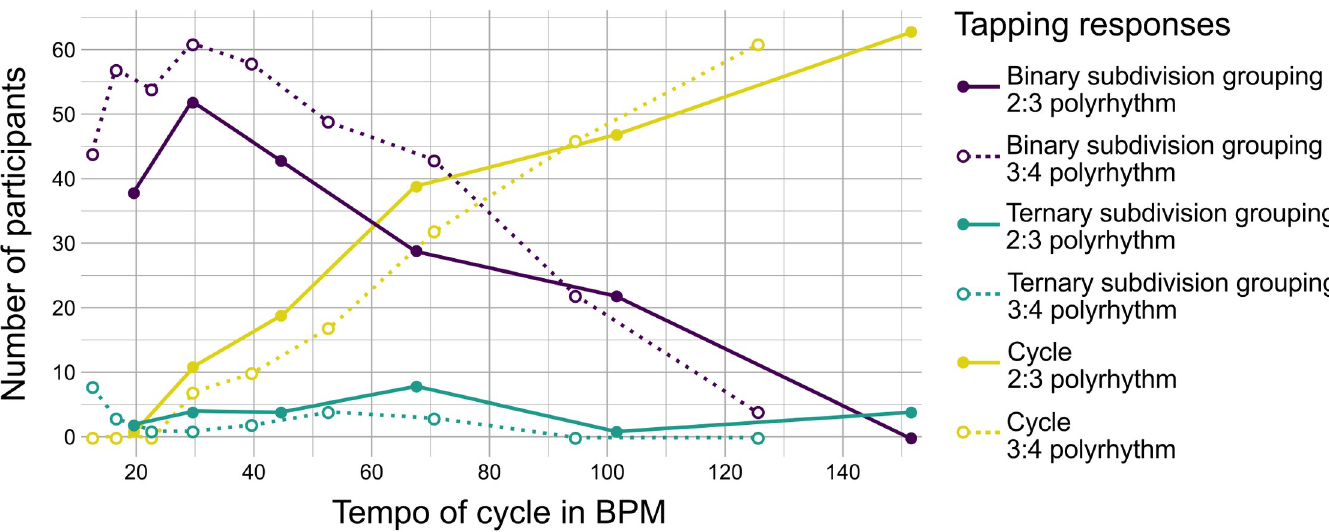
Fig 3. Participants’ preference for subdivision grouping in the tempo experiment. The different lines in the plot represent responses with binary (dark purple) or ternary (green) subdivision grouping. At slow and moderate tempi, most participants tapped in time with one of the response categories that admitted a binary subdivision regardless of tempo. At faster tempi, participants switched to tapping in time with the cycle (bright yellow). Only a few participants’ tapping behavior corresponded to ternary subdivision grouping. Binary subdivision in 2:3 include fast pulse train and fast pulse train—half tempo . Binary subdivision in 3:4 include slow pulse train , slow pulse train—half tempo , slow pulse train—double tempo , and fast pulse train—half tempo . Ternary subdivision in 2:3 include slow pulse train and slow pulse train- double tempo . Ternary subdivision in 3:4 include fast pulse train and fast pulse train—double tempo . For an overview of binary and ternary metrical categories, see also the color-coded tapping responses in Fig 4. Note that subdivision grouping is indistinguishable at the all subdivisions (not shown) and cycle levels.